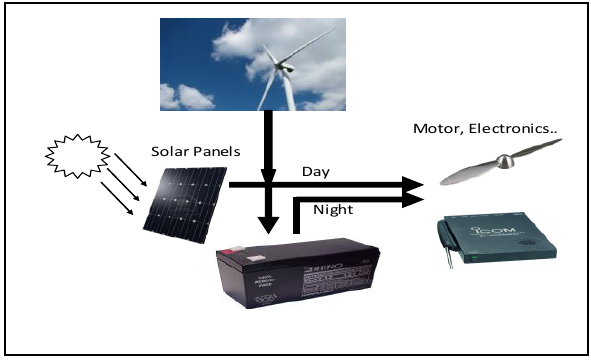
Figure.1 Solar aeroplane basic